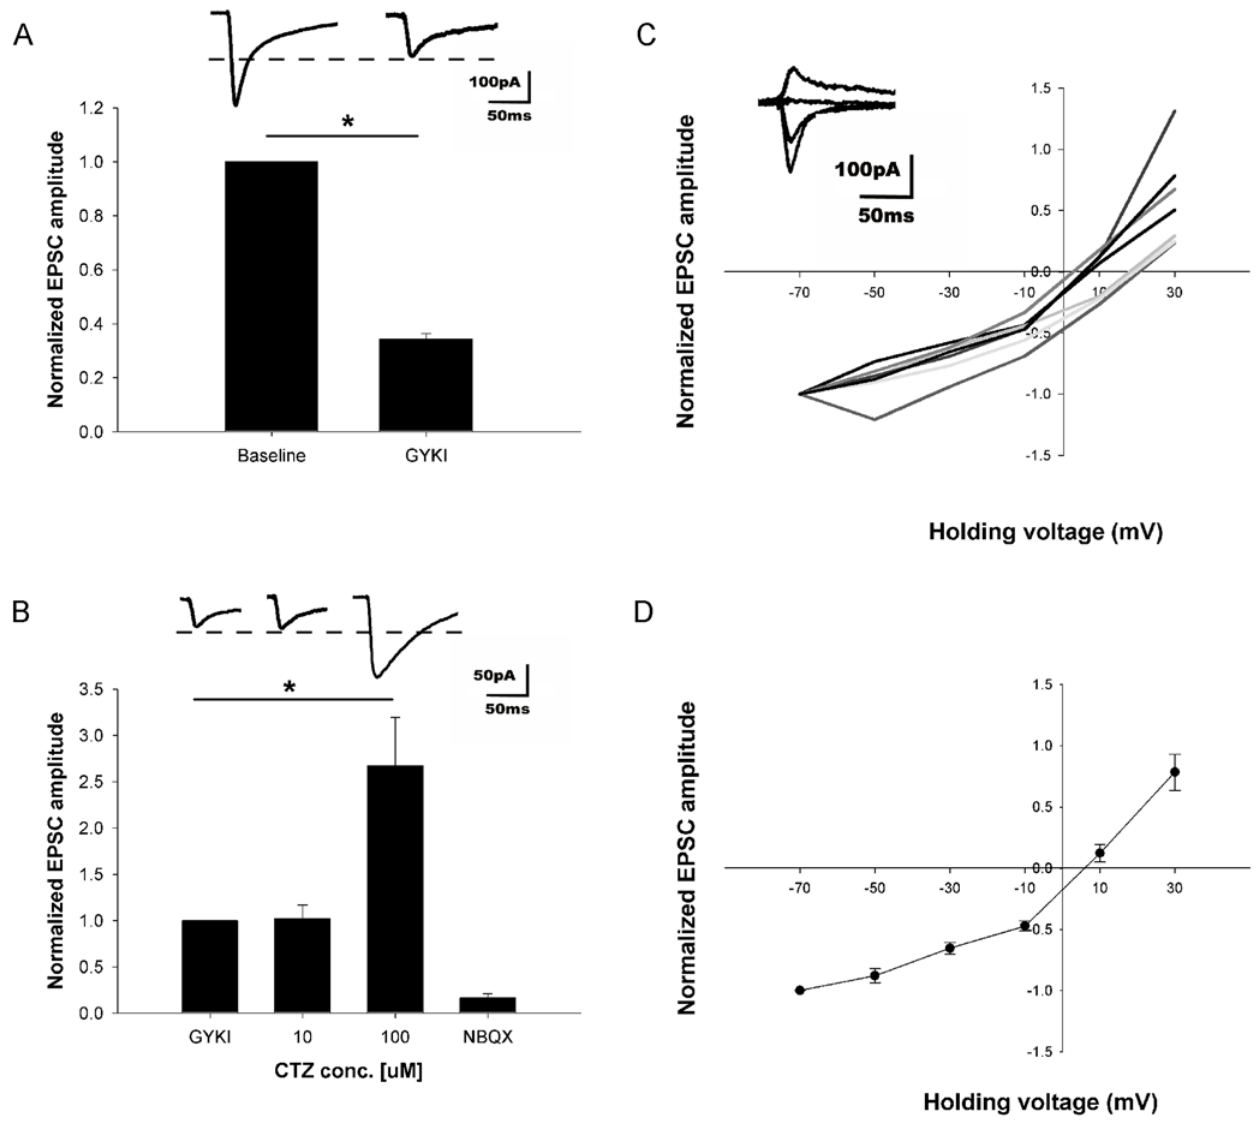
Figure 4. IV curve and characterization of kainate receptors on LIII mEC pyramidal neurons using photolytic uncaging of glutamate. (A) Photolytic uncaging of glutamate at the cell soma elicited inward currents, which were reduced to 34.32% ( 6 2.05%; p , 0.01; n=5) of the baseline value in the presence of GYKI (20 m M). (B) At 20 m M of GYKI no residual AMPA current is seen as there is no potentiation of the resultant EPSC upon application of AMPAR desensitization blocker CTZ (10 m M; p =0.956; n=4). However, at a higher concentration of CTZ (100 m M), the effect of GYKI is antagonized ( p , 0.01; n=6). In the presence of GYKI, APV and Gabazine, the holding membrane potential was changed in steps of 20 mV from 2 60 mV to 40 mV and at each step, 5 responses (5 laser flashes with a inter-stimulus interval of 30 seconds) were recorded by uncaging glutamate over the cell soma. (C) The peak current for each individual cell (n=7) is plotted against the membrane potential along with the corresponding superimposed current traces (inset). (D) Group data (n=7). A linear relationship between voltage and current, both at negative and positive potentials suggested the KARs on LIII mEC pyramidal neurons to be mostly of the Ca 2 + impermeable edited form.